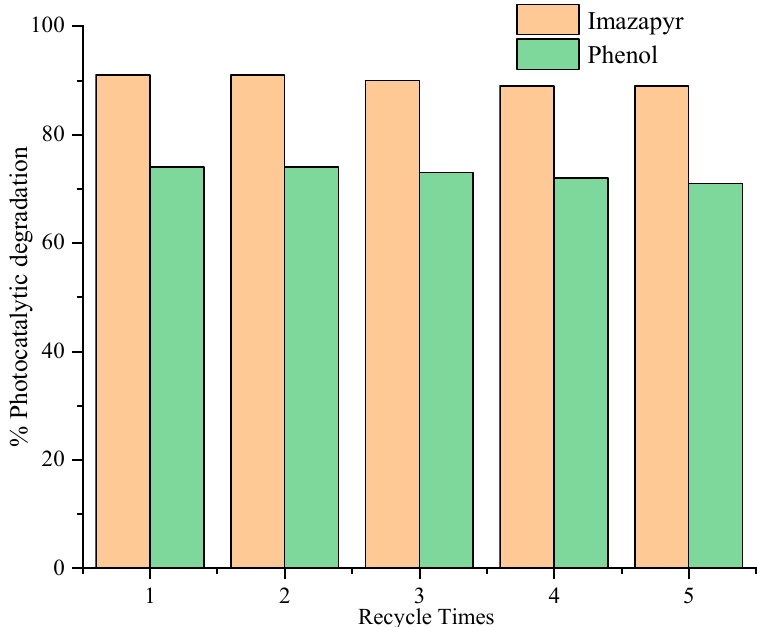
Figure 4. Repeated cycles up to 5 times for photodegradation of imazapyr and phenol over mesoporous TiO 2 nanoparticles. Illumination time, 60 min; photocatalyst loading, 1 g L − 1 ; pH = 3; T = 25 ± 1 °C; reaction volume 50